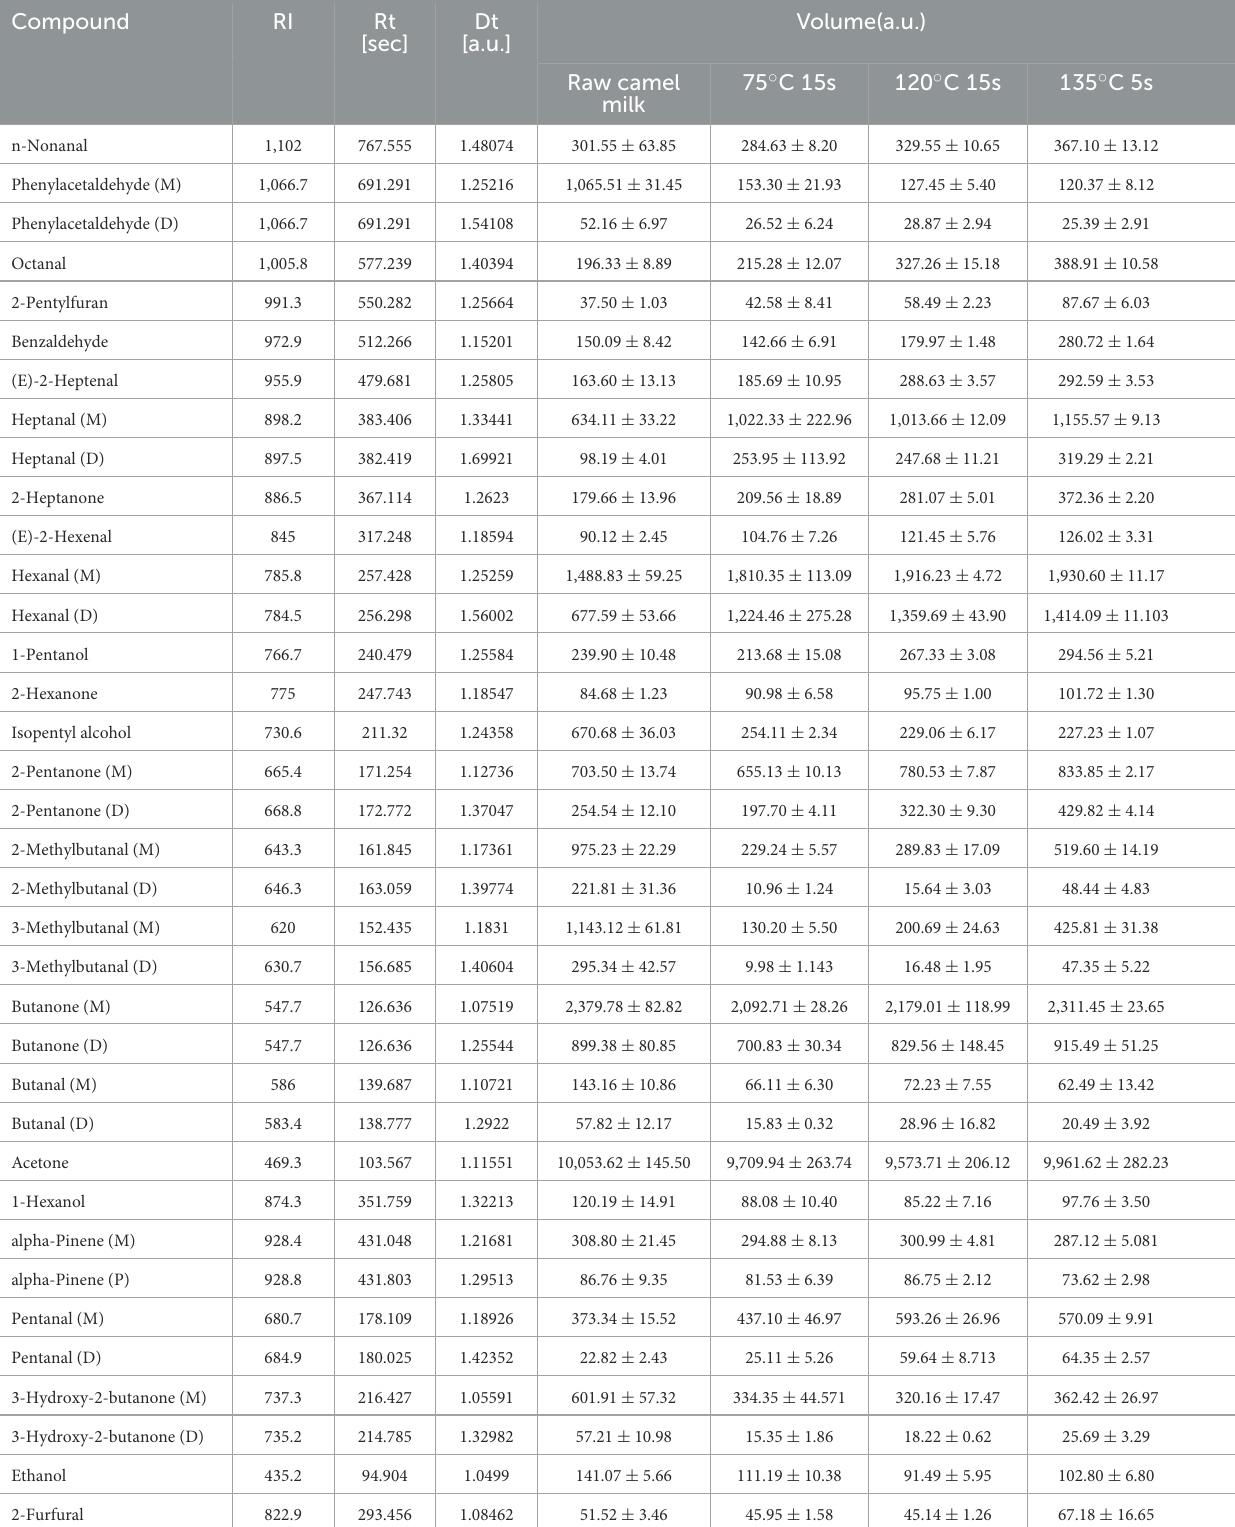
TABLE 2 Comparison of integrated peak area of volatile compounds in camel milk of different heat treatments.